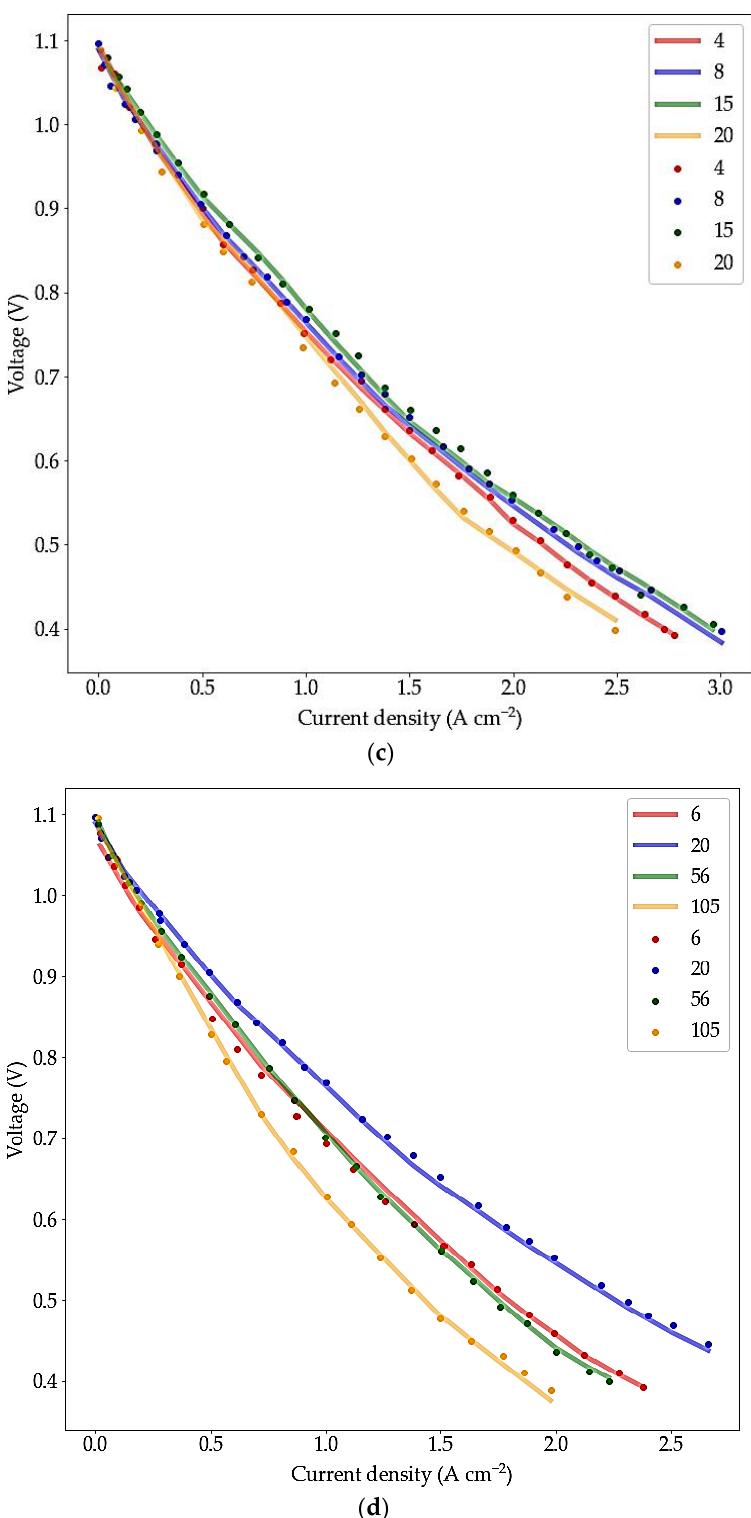
Figure 10. MLPs prediction and experimental data of cell current–voltage dependency at ( a ) different operation temperatures; ( b ) different ASL porosity (at 800 ℃ ); ( c ) different electrolyte thickness (at 800 ℃ ); and ( d ) different CFL thickness (at 800 ℃ ); the scattered dots related to the experiments data points, and the lines related to the model prediction trends.